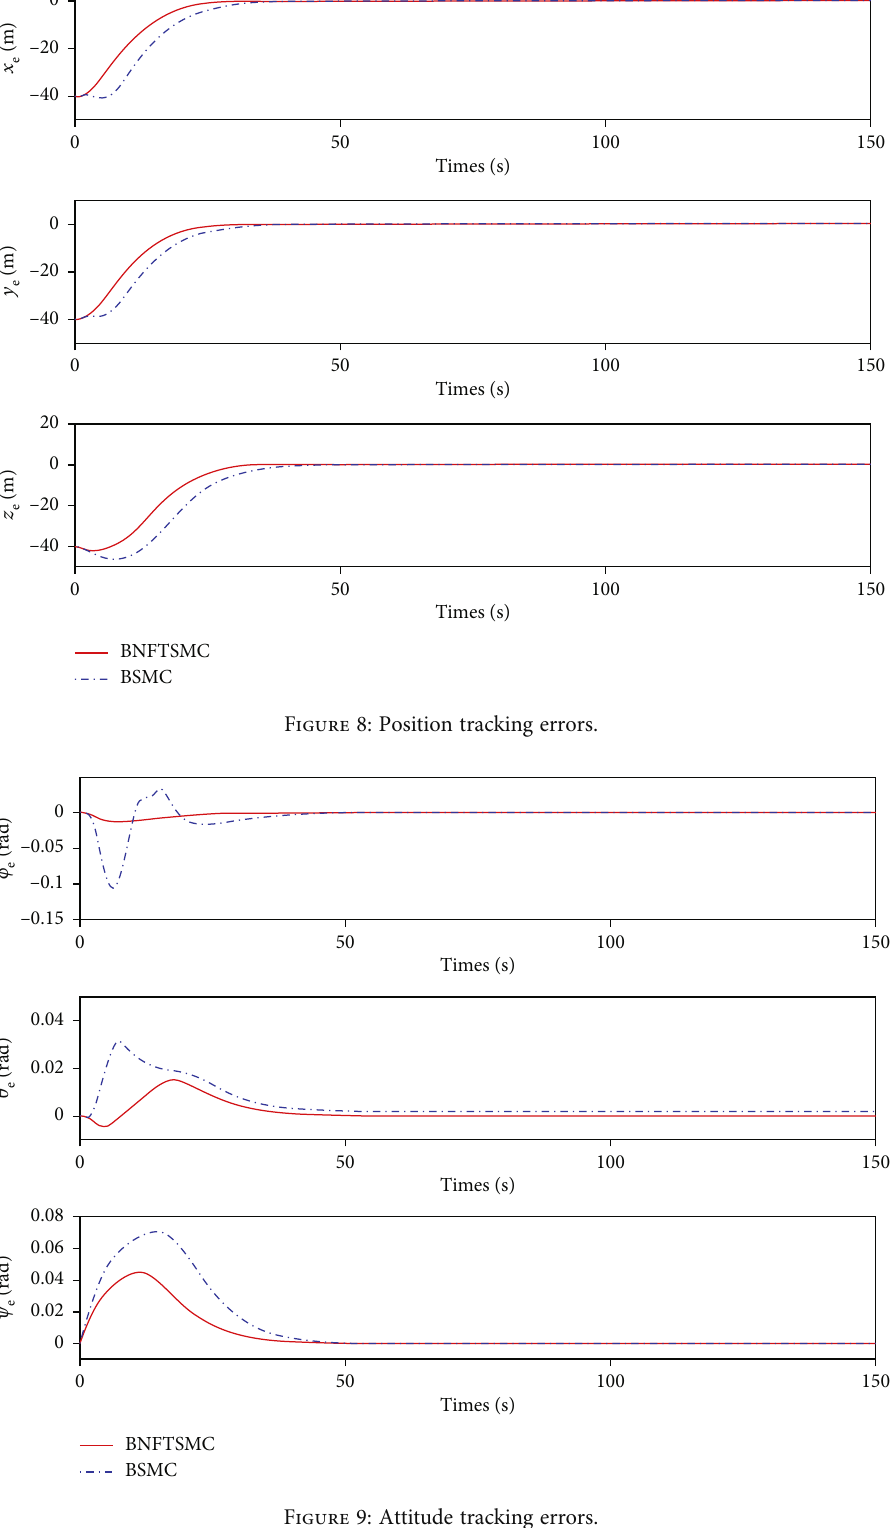
Figure 8: Position tracking errors.